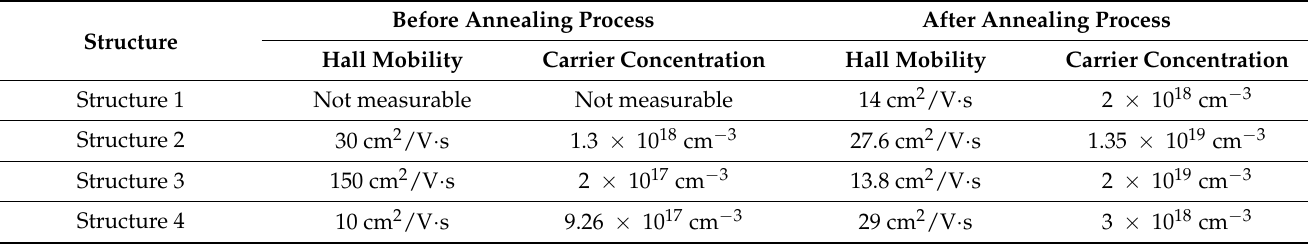
Table 2. Summary of the hall measurement data performed from all of the superlattice layers listed in Table 1.